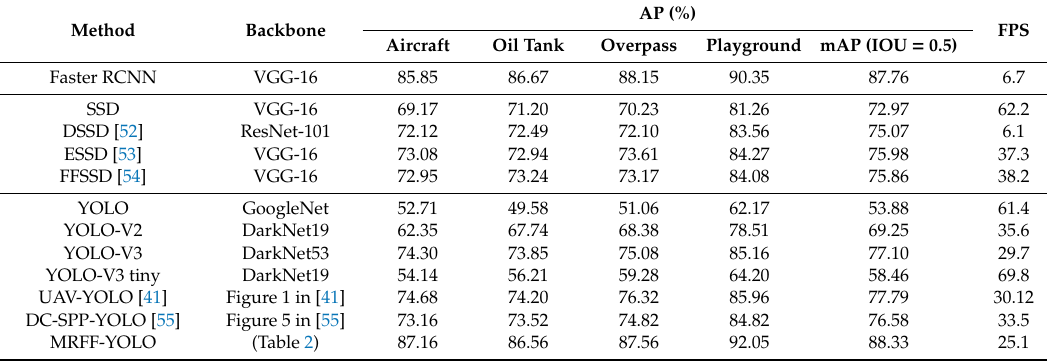
Table 9. The contrastive results of di ff erent categories in the RSOD dataset.